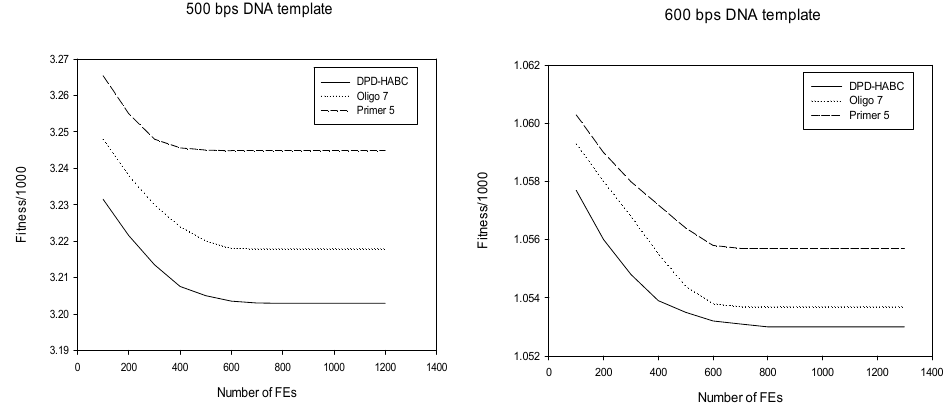
Table 2. Comparison of three methods on 500 bps DNA template.